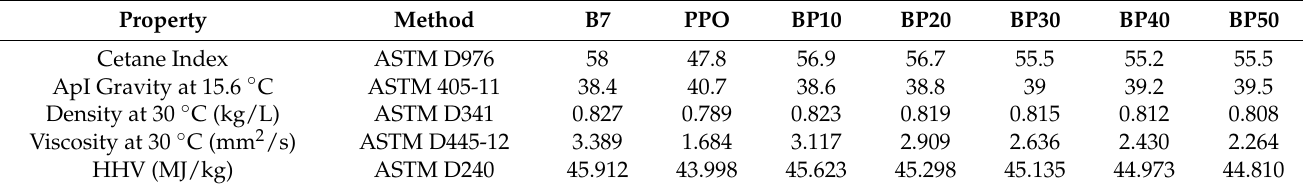
Table 1. PPO and B7 fuel